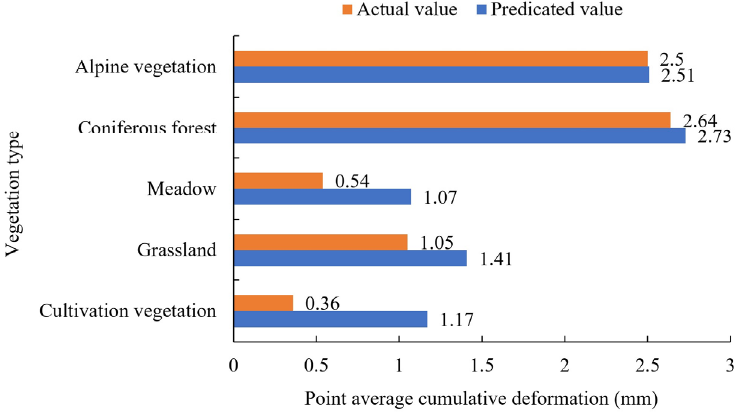
Figure 18. Comparison of actual and predicted values of cumulative surface deformation under different vegetation conditions.